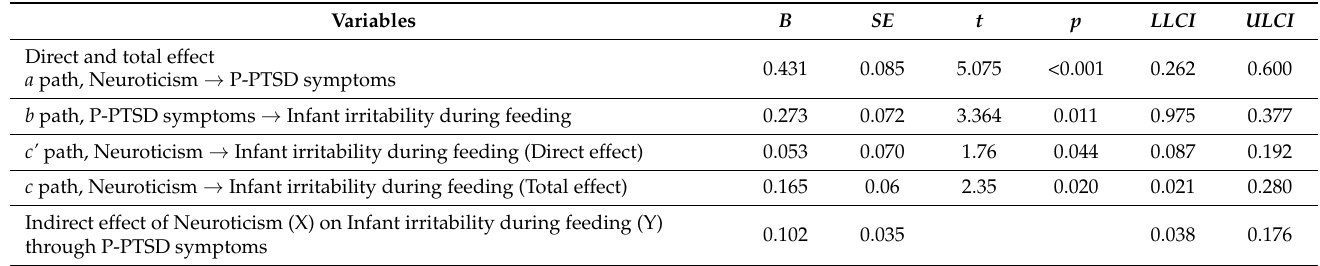
Table 3. Mediation effect of P-PTSD symptoms on infant irritability during feeding.